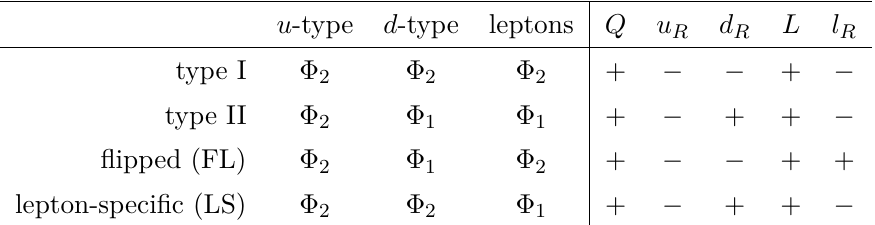
Table 1 . Four left rows: the four Yukawa types of the Z 2 -symmetric 2HDM, stating which Higgs doublet couples to the different fermion types. Five right columns: corresponding Z for the quark doublet Q , the up-type quark singlet u doublet L , and the lepton singlet l